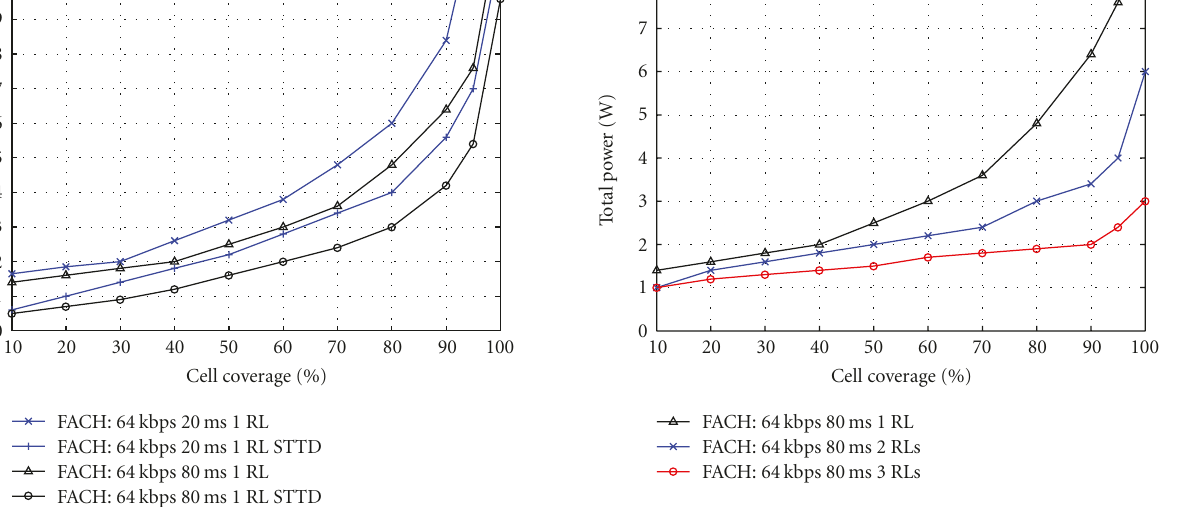
Figure 4: FACH Tx power with Usage of longer TTI and Space Diversity (RL: Radio Link)